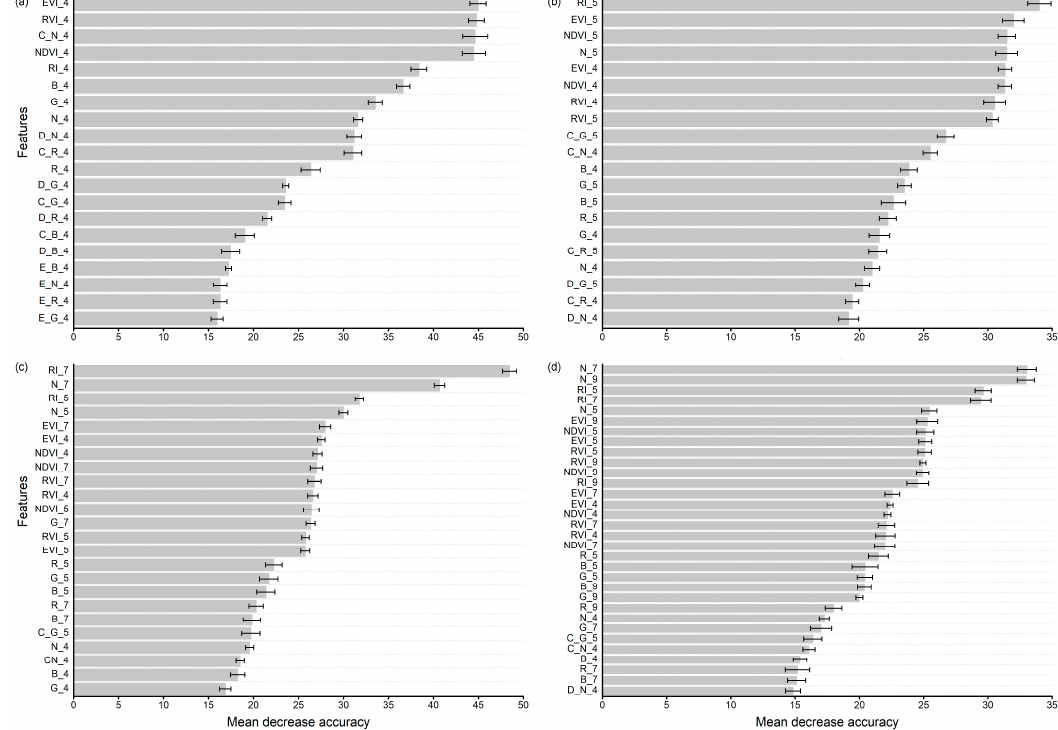
Figure 9. Importance of RF feature sets for in-season crop mapping at different crop growth seasons: ( a ) ES; ( b ) SP; ( c ) SM; ( d ) AT. B blue spectral band; G green spectral band; R red spectral band; N near-infrared spectral band; E gray-level co-occurrence matrix entropy; D gray-level co-occurrence matrix dissimilarity; C gray-level co-occurrence matrix correlation; 4 features extracted from the early spring imagery; 5 features extracted from the spring imagery; 7 features extracted from the summer imagery; 9 features extracted from the autumn imagery; ES in the early spring season; SP in the spring season; SM in the summer season; AT in the autumn season.